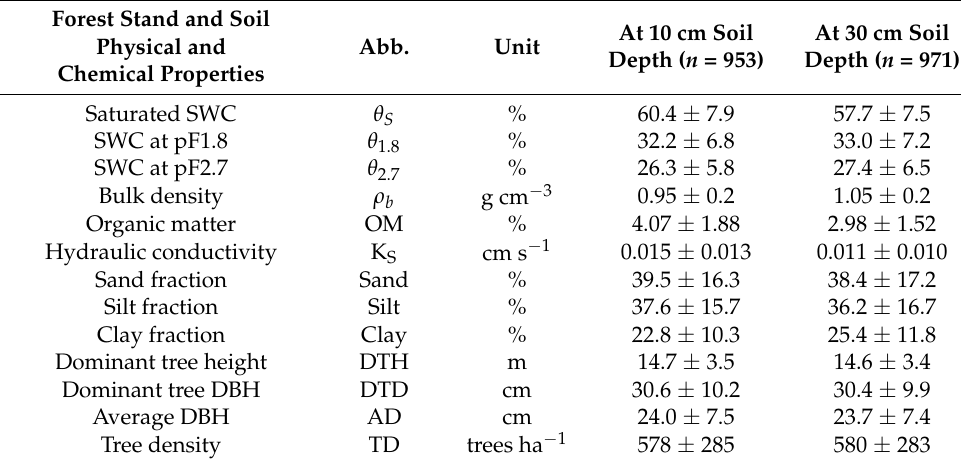
Table 1. Measured forest stand and soil physical and chemical properties. Forest Stand and